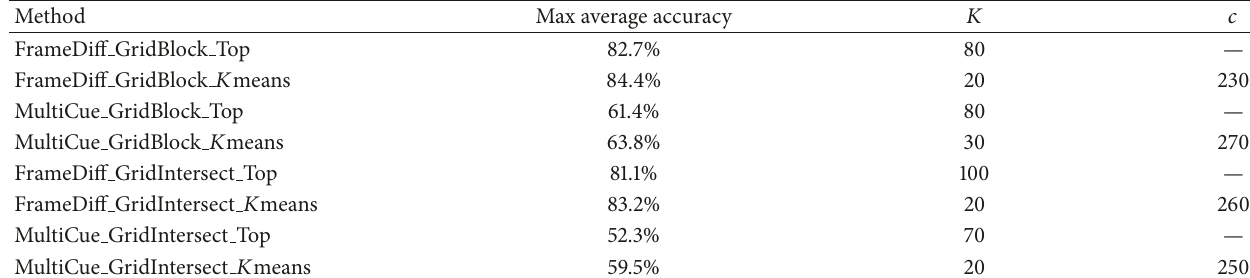
Table 6: Combined methods constructed from all foreground detection, OF extraction, and feature normalization methods. Combined abbreviation Foreground detection and OF extraction FrameDiff GridIntersect Top MultiCue GridIntersect Top FrameDiff GridBlock Top MultiCue GridBlock Top MultiCue GridBlock FrameDiff GridIntersect 𝐾 means FrameDiff GridIntersect MultiCue GridIntersect 𝐾 means MultiCue GridIntersect FrameDiff GridBlock 𝐾 means FrameDiff GridBlock MultiCue GridBlock 𝐾 means MultiCue GridBlock 𝐾 means Table 7: Maximum average accuracy of all methods with 𝐾 ranging from 10 to 100 and 𝑐 ranging from 10 to 400. Method FrameDiff GridBlock Top FrameDiff GridBlock 𝐾 means MultiCue GridBlock Top MultiCue GridBlock 𝐾 means FrameDiff GridIntersect Top FrameDiff GridIntersect 𝐾 means MultiCue GridIntersect Top MultiCue GridIntersect 𝐾